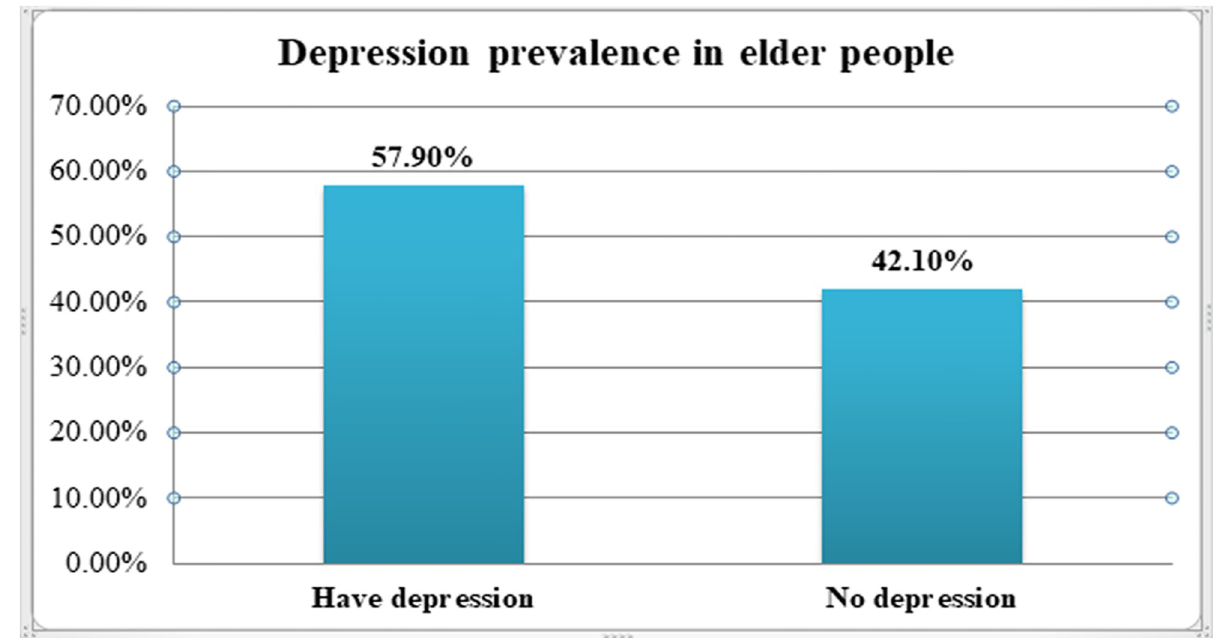
Fig 2. Prevalence of depression in older adults people in Bahir Dar city administration, northwest, Ethiopia, 2020 (n = 423).